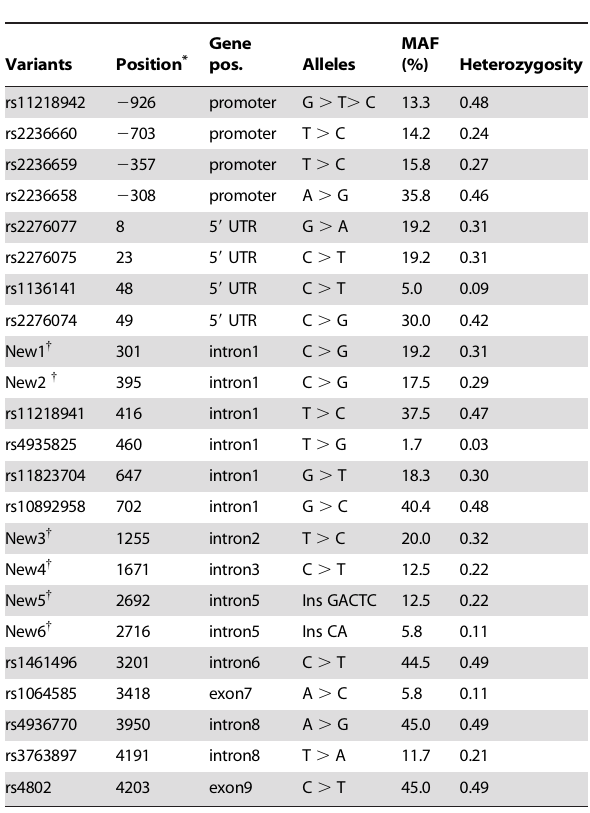
Table 1. Variants discovered by sequencing all HSPA8 exons and introns and 1 Kb upstream of transcript start site in 60 unrelated